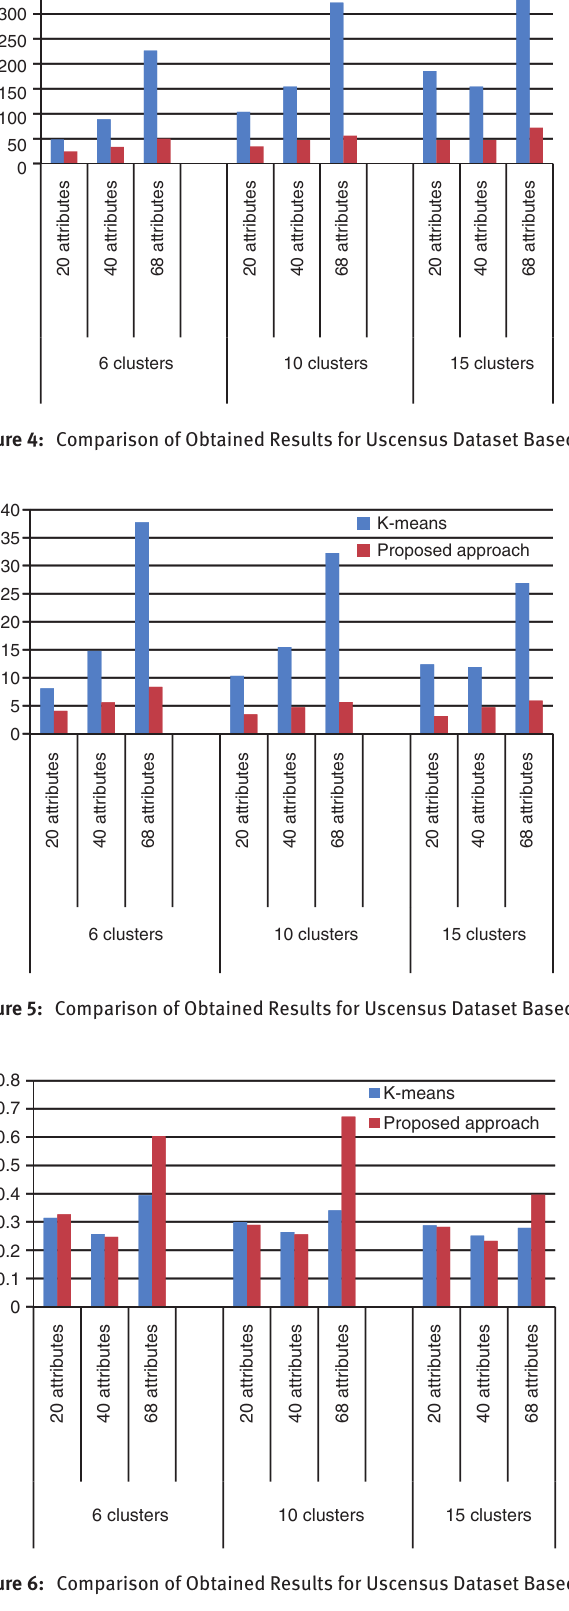
Figure 6: Comparison of Obtained Results for Uscensus Dataset Based on Silhouette